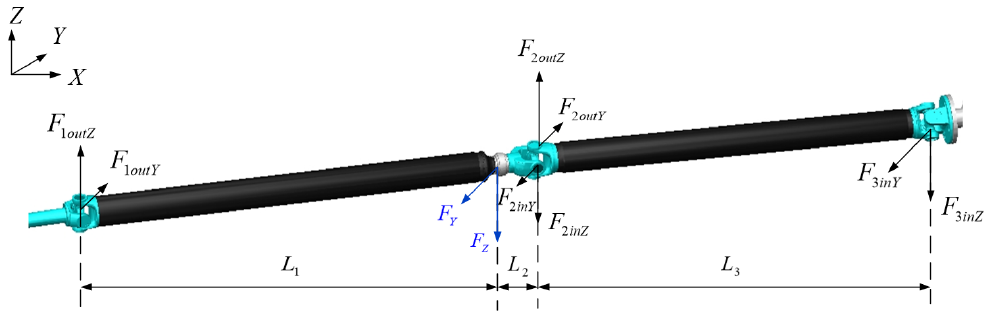
Figure 3. Forces analysis of the drive shaft.